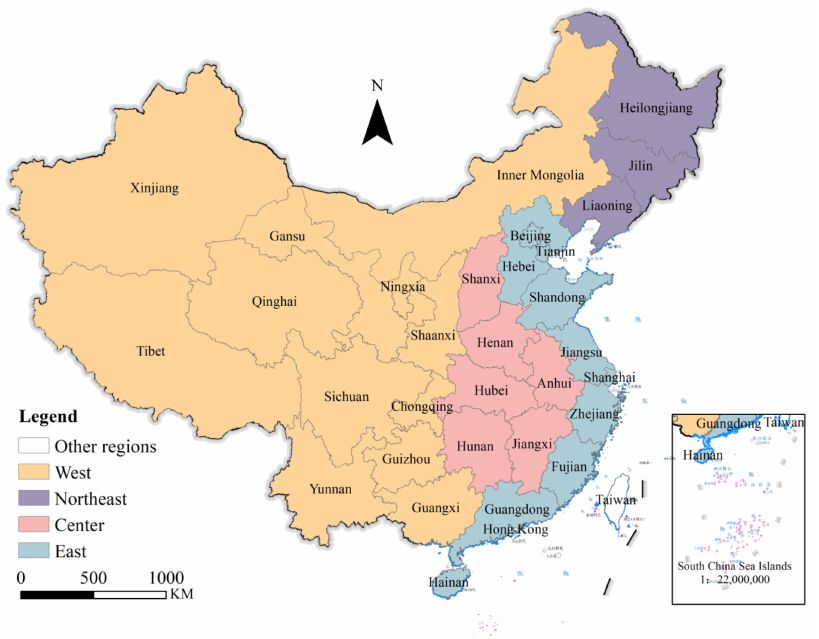
Figure 1. Division of four regions in China. Note: the map is drawn according to the Standard Map Service Website of the Ministry of natural resources (map review No. GS (2020) 4630).